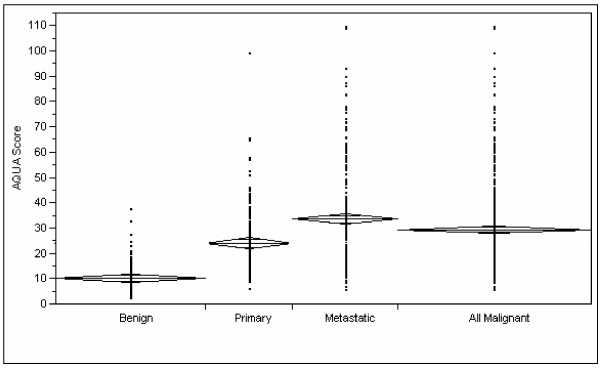
Unpaired t-tests showing significant differences in expression of XIAP between benign and malignant specimens (p < 0.0001), and significant differences between primary and metastatic lesions (p < 0.0001).